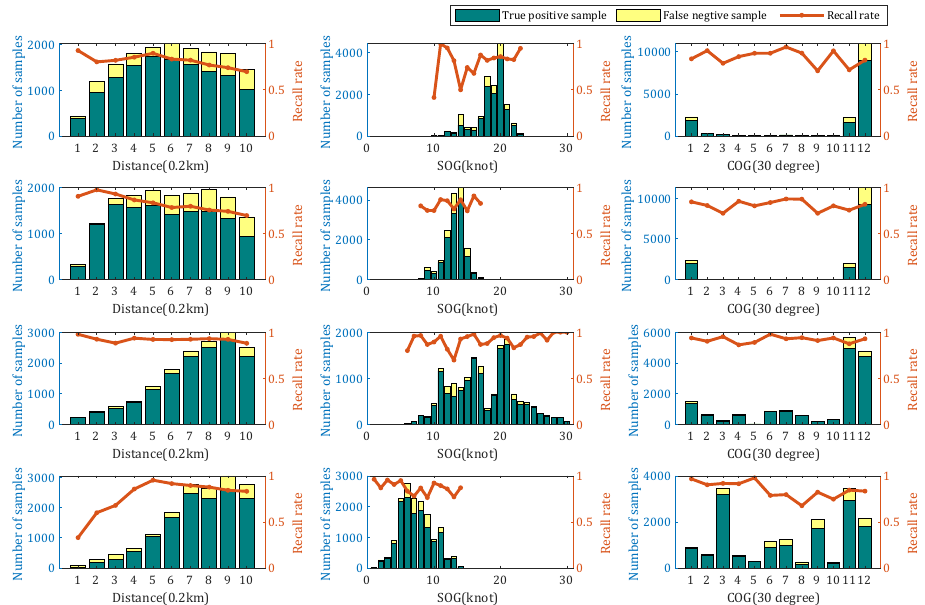
Figure 3. Operative condition and classification results analysis. Four rows from top to bottom represent Cargo, Tanker, Passenger ship and Tug, respectively. Histograms are the number of samples under different operative conditions. Yellow and green histograms represent the false negative samples and true positive samples, respectively. Orange lines are recall